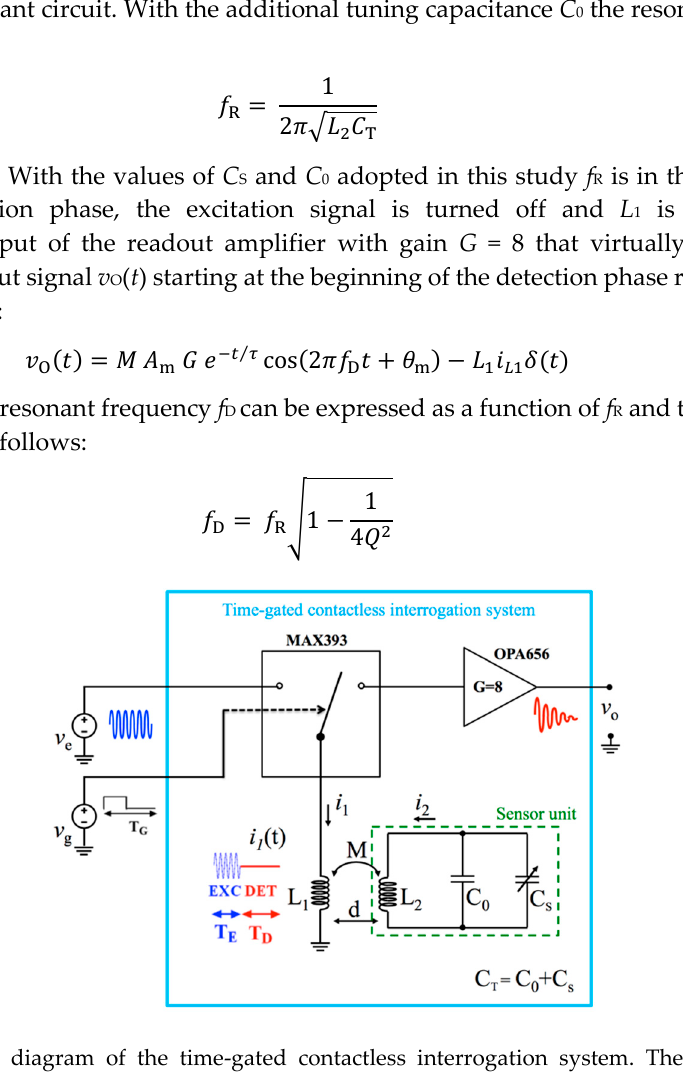
Figure 1. Block diagram of the time-gated contactless interrogation system. The sensor unit is represented by the secondary coil L 2 and the capacitance C T = C 0 + C S , where C S represents the sensor